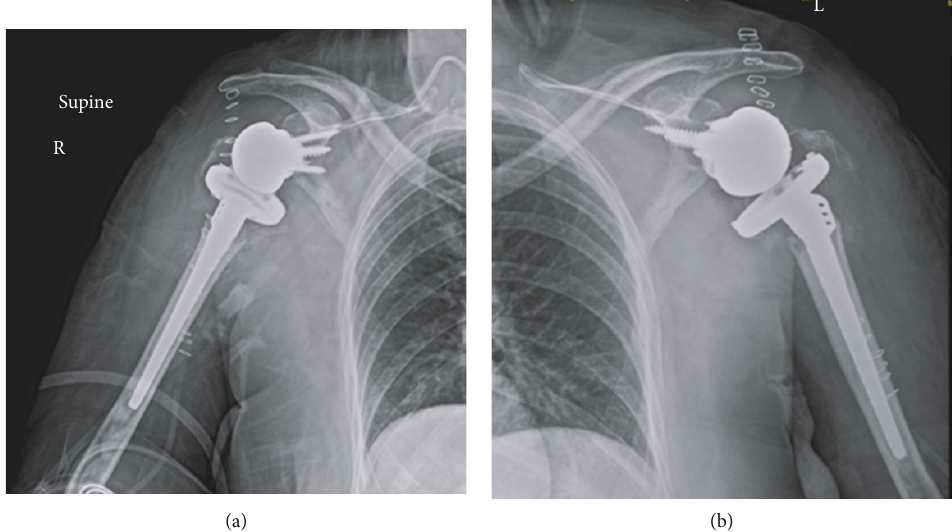
Figure 3: (a) Postoperative X-ray radiograph of the right shoulder showing reverse shoulder arthroplasty. (b) Postoperative X-ray radiograph of the left shoulder showing reverse shoulder